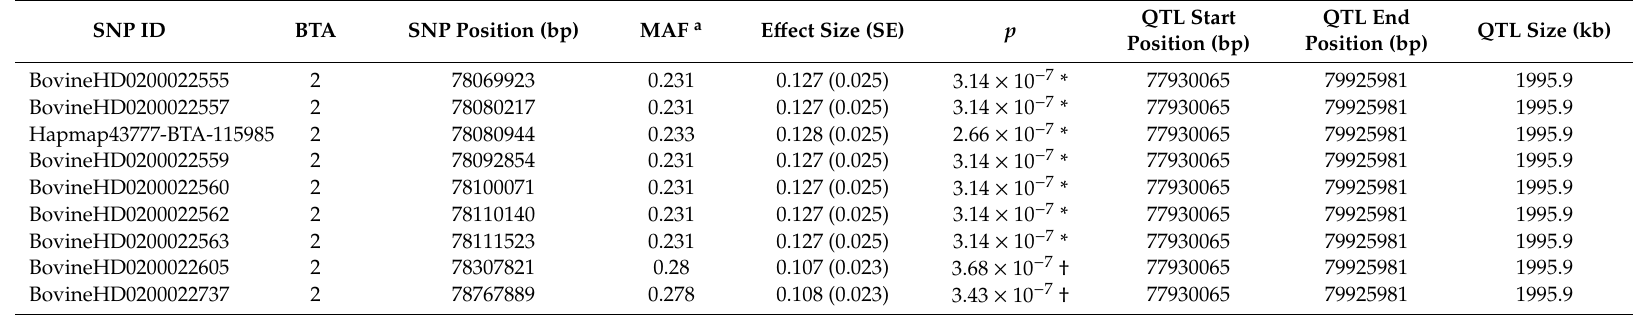
Table 4. Significant and suggestive SNPs detected from the linear mixed model genome-wide association analysis using quantitative phenotypes and their defined